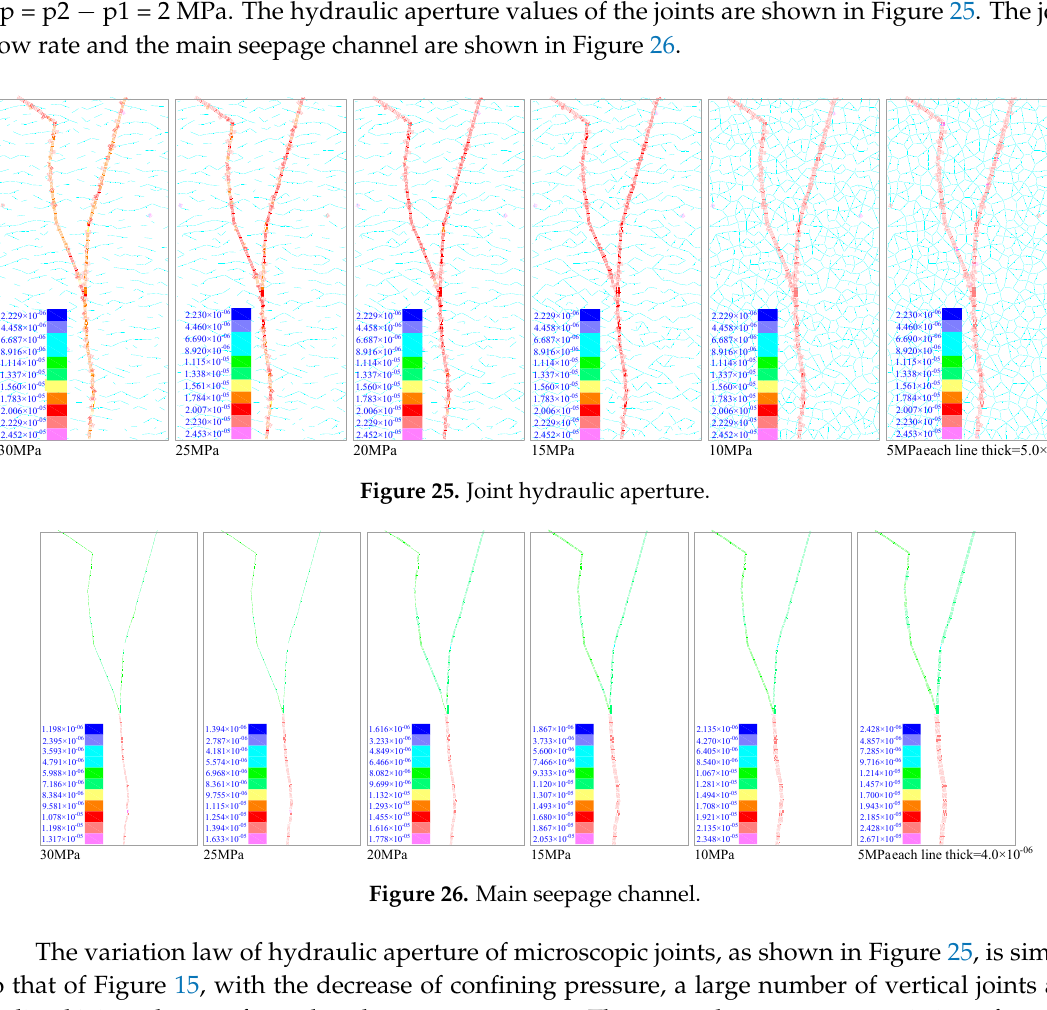
Figure 24. Seepage results of different fracture forms.